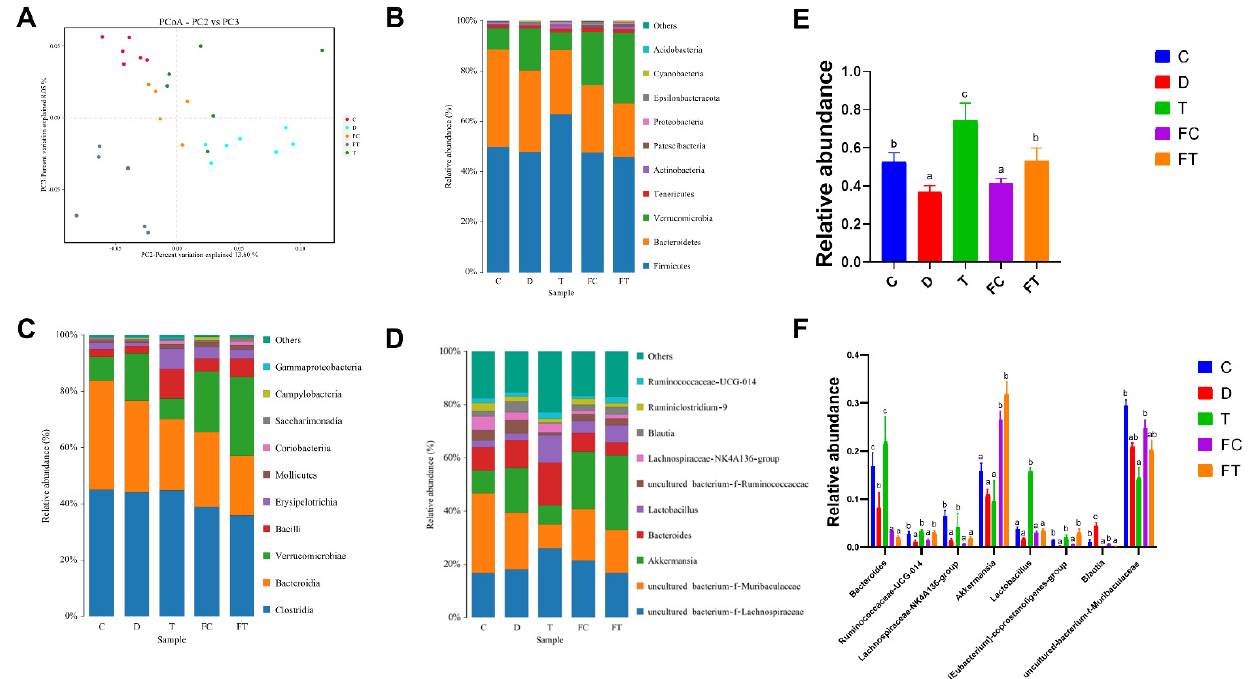
Figure 6. Taxifolin and FMT altered gut microbiota in DSS-induced intestinal mucositis model mice. ( n = 7). ( A ) PCoA score based on weighted Unifrac metrics was different in each group; ( B ) Relative abundances of bacterial phyla level among five mice groups; ( C ) Relative abundances of bacterial class level among five mice groups; ( D ) Relative abundances of bacterial genus level among five mice groups; ( E ) the relative abundance of phylum; ( F ) the relative abundance of genus. The letters abcd are significant markers, and any difference with one of the same marker letters is not significant, and any difference with different marker letters is significant.